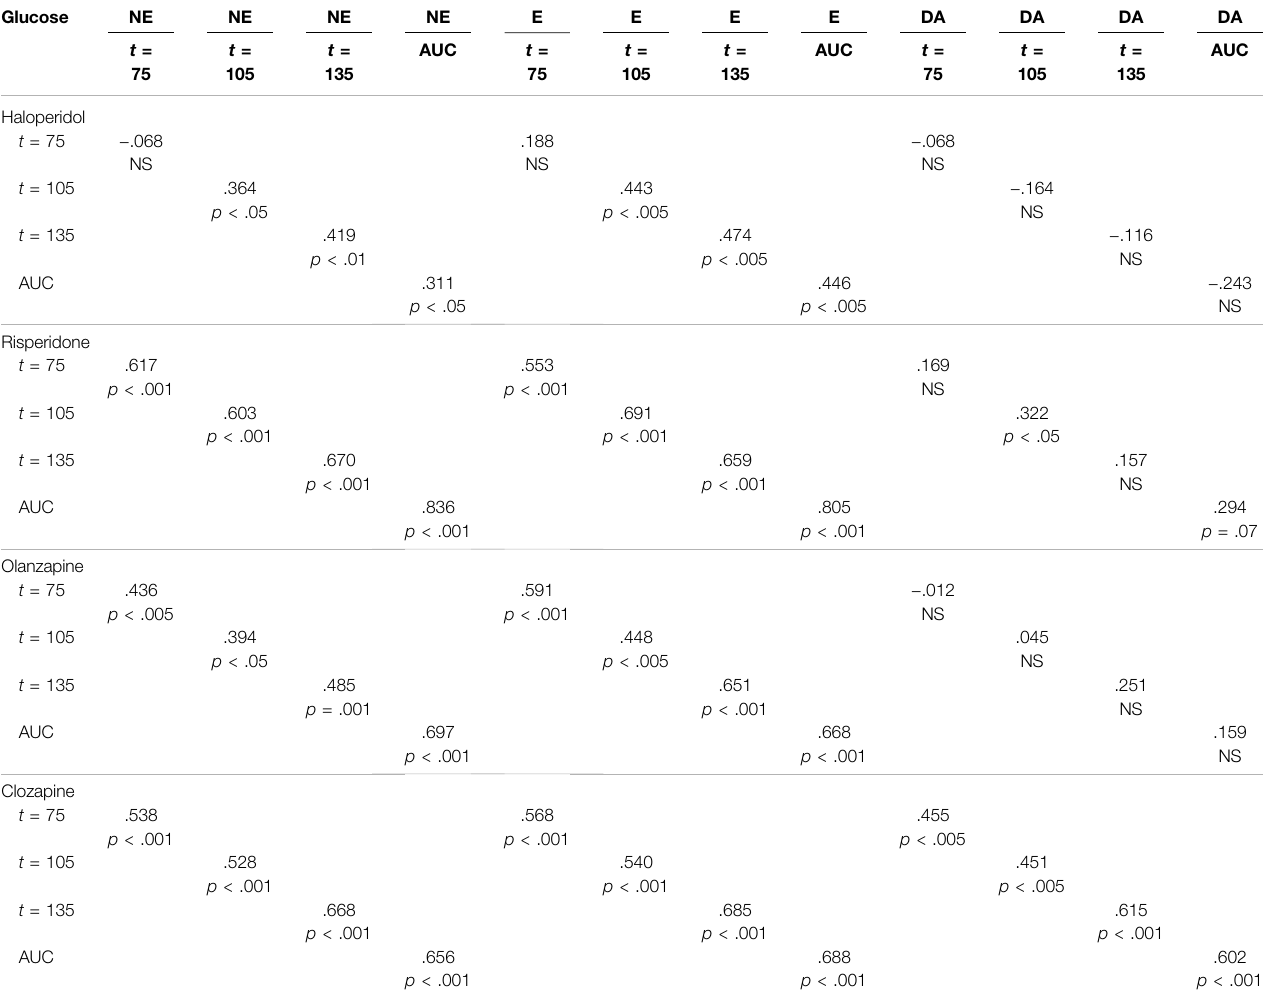
TABLE 1 | Associations between glucose intolerance and plasma catecholamine levels in adult female rats.